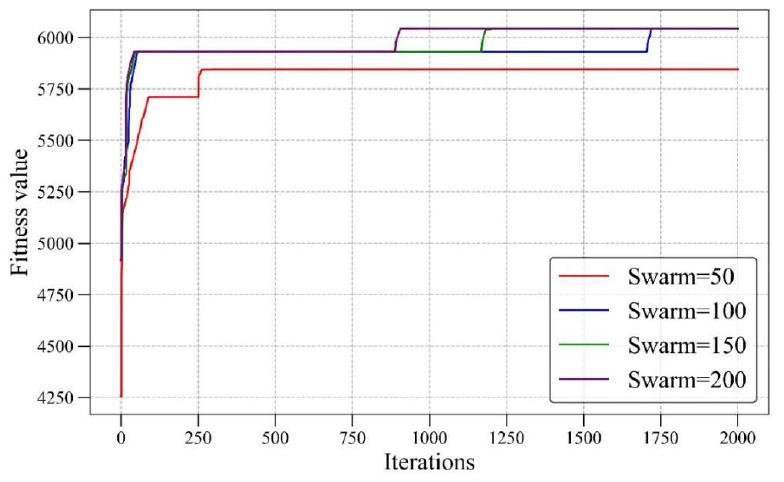
Figure 10. The fitness variation in ABC.